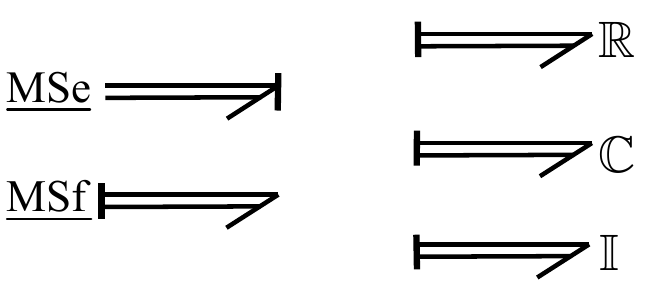
Figure 7. Multiport